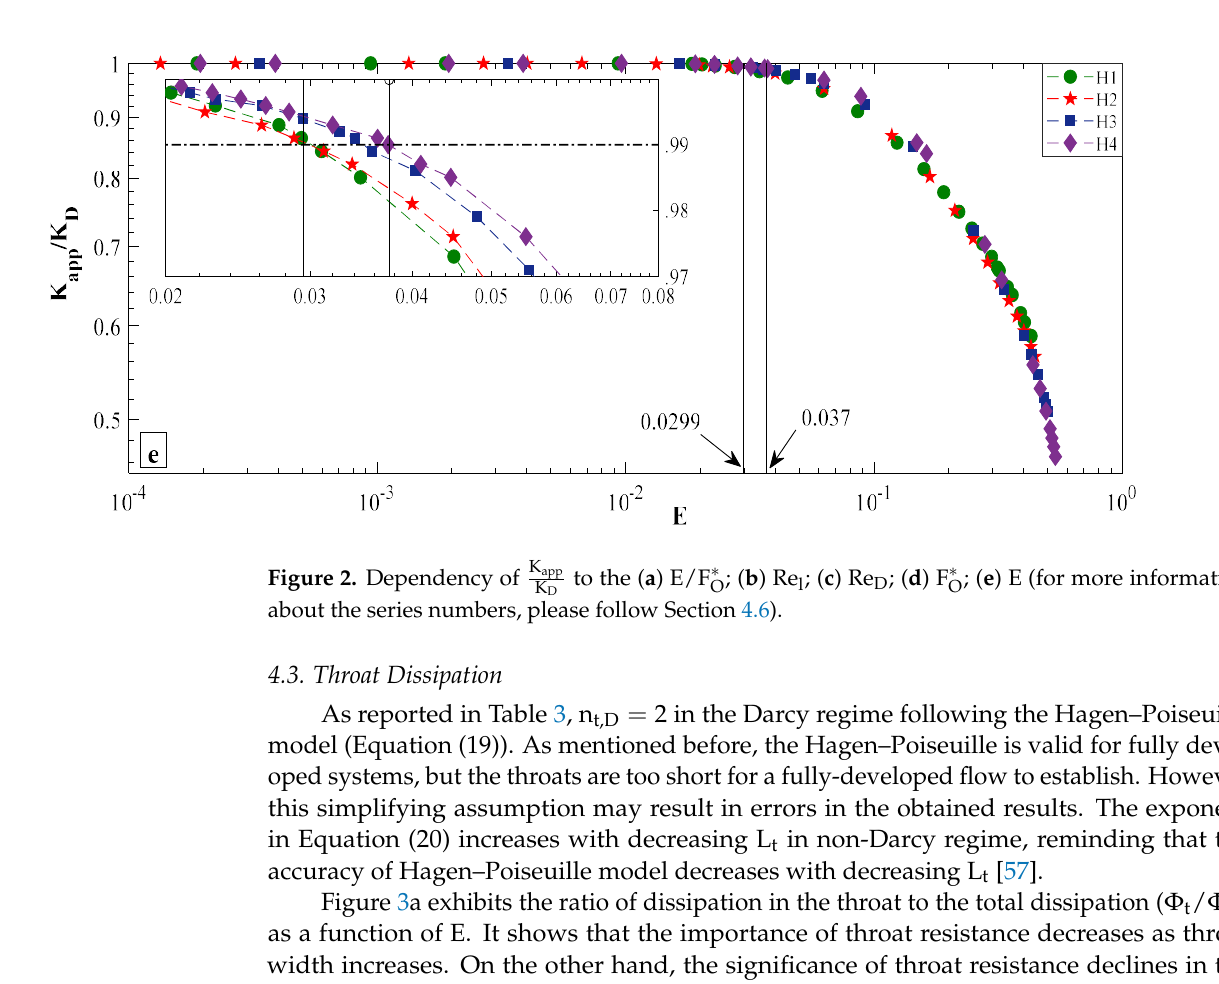
to the ( a ) E/F ∗ ; ( b ) Re l ; ( c ) Re D ; ( d ) F ∗ O K D